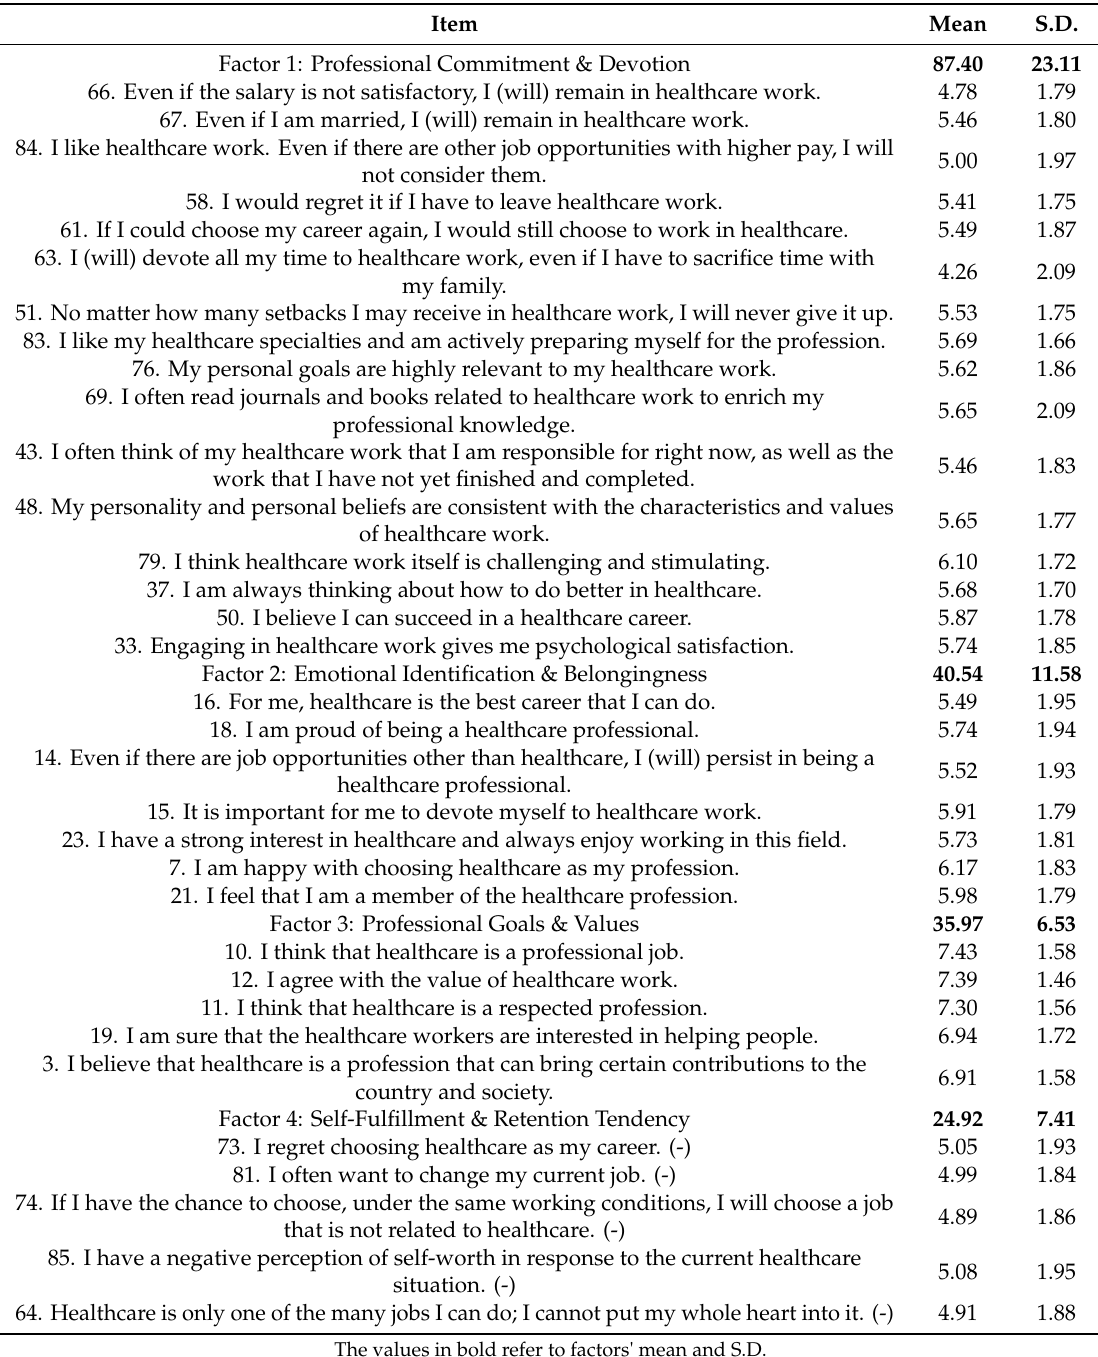
Table 3. Average item scores and standard deviations of the exploratory factor analysis (EFA) model for Professional Identity Scale for Healthcare Students and Professionals